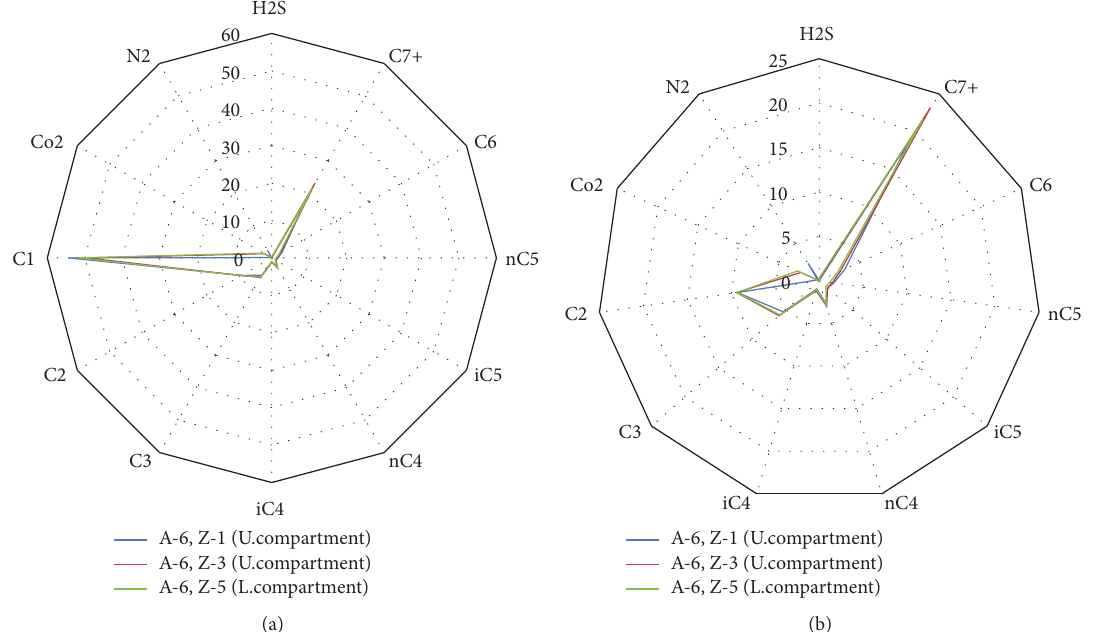
Figure 9: The oil composition (obtained from PVT analysis) of upper (U.) and lower (L.) compartments, in well A-6, (a) with C1 and (b) without C1 component.